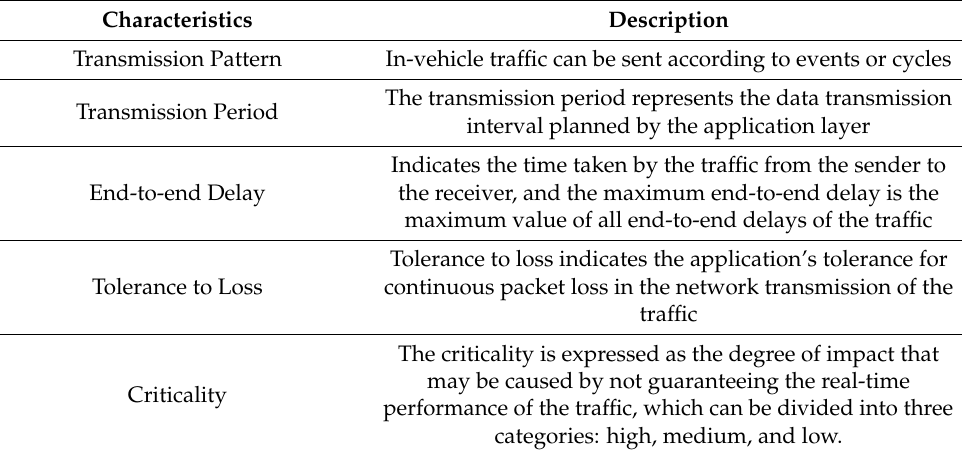
Table 3. Traffic characteristics of the in-vehicle